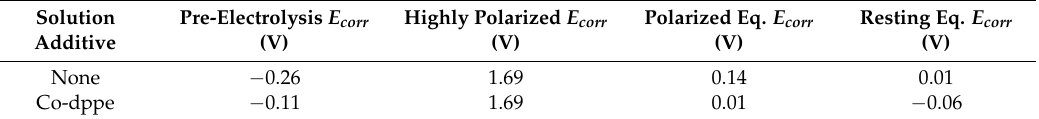
Table 3. E corr values (V vs. RHE) measured under open-circuit conditions during different equilibrium states of the PbAg electrode in 1.6 M H 2 SO 4 . The “Polarized Equilibrium” state accessed by LSV after electrolysis is highlighted in bold